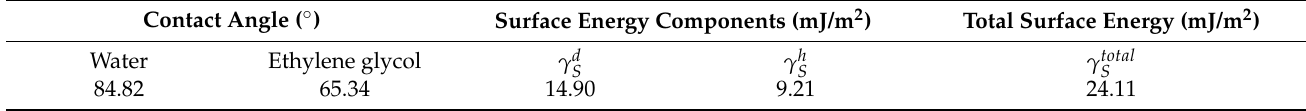
Table 5. Contact angles and SFE of bitumen